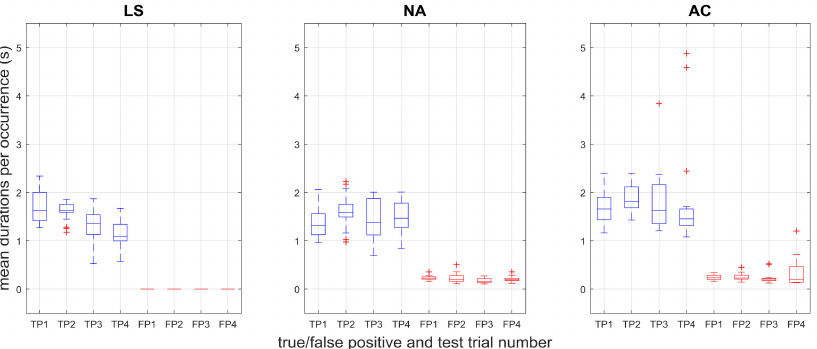
Figure 7. Mean duration (seconds) of true positive (TP) and false positive (FP) responses across test trials for the three controllers. Significant differences ( p < 0.01) were found between true and false positive durations within each controller. Multi-grasps were removed in the data shown here.